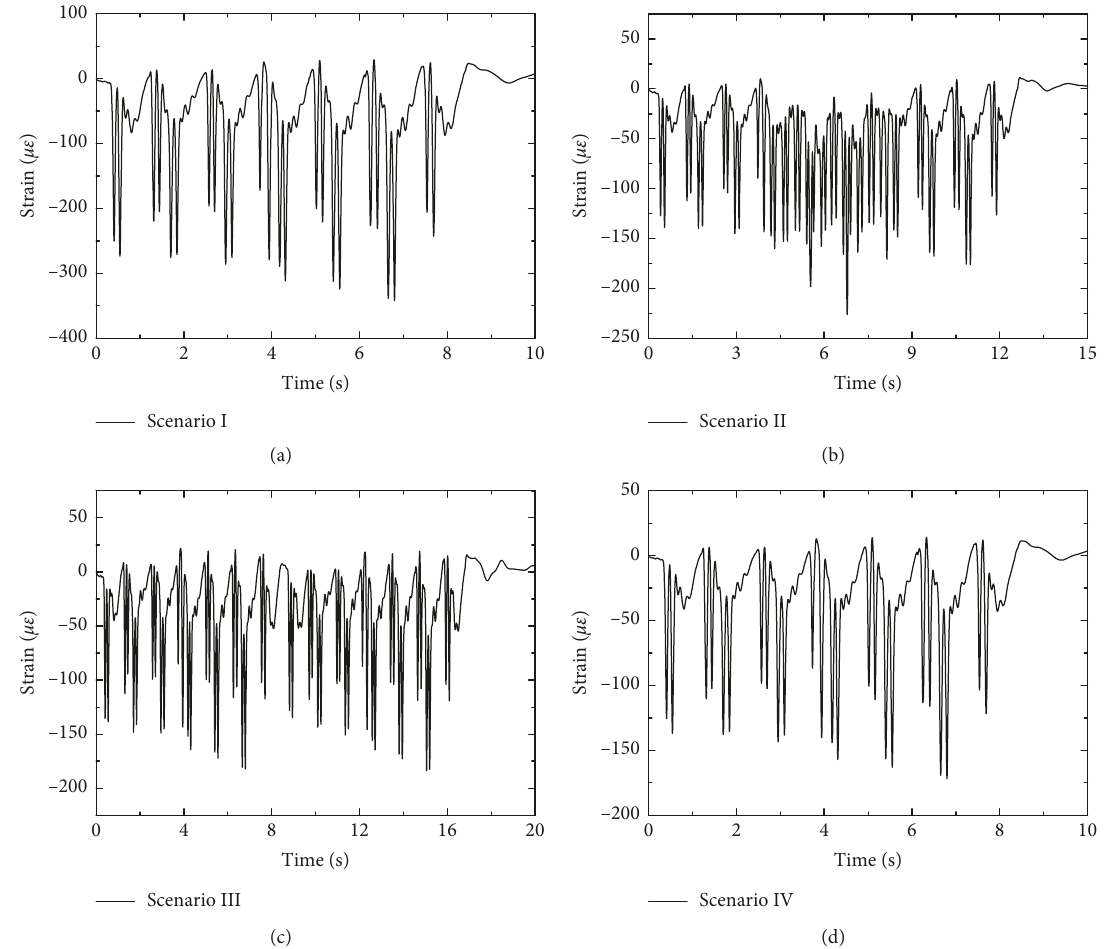
Figure 16: The strain curve of A 1 in time domain. (a) Scenario I. (b) Scenario II. (c) Scenario III. (d) Scenario